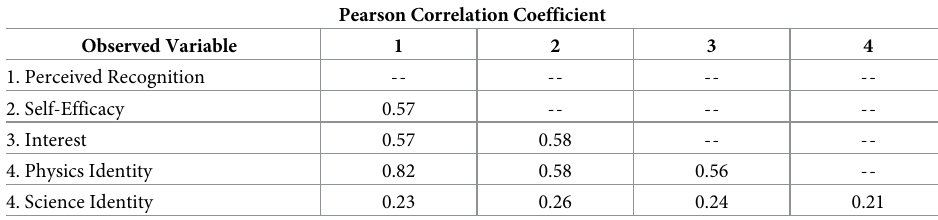
Table 2. Pearson inter-correlations are given between all constructs based upon student responses to the motiva- tional beliefs survey at the end of physics